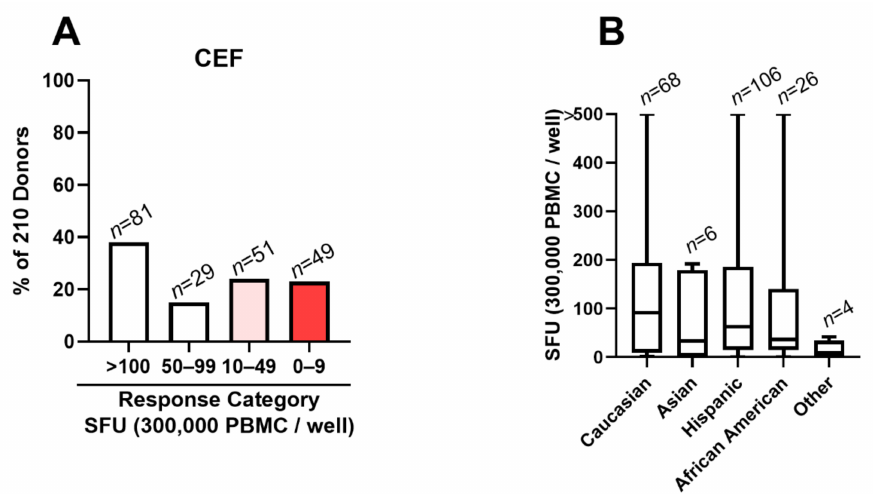
Figure 2. CEF peptide pool-triggered recall response in 210 healthy human donors. A standard 24 h IFN- γ ImmunoSpot ® assay was performed testing the CEF peptide pool induced SFU numbers. ( A ) Response magnitudes have been divided into the specified SFU categories. Representative wells for these response categories are shown in Figure S1. The percentage of subjects falling in each response category is shown on the Y -axis, and the number of subjects in each category is specified above the bars. ( B ). The breakdown of CEF responses by race is shown as a box and whiskers